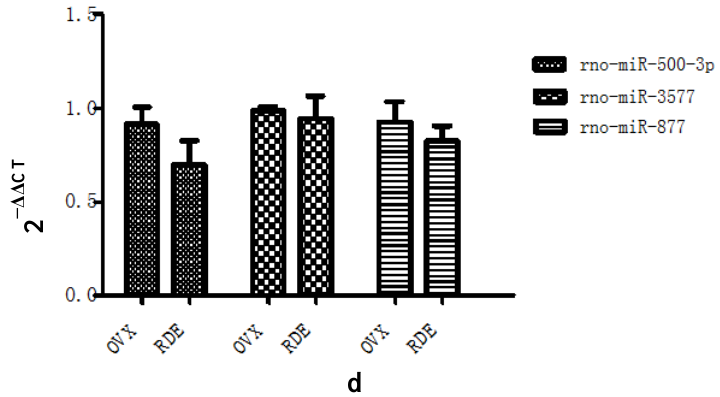
Figure 3. Validation of the differential expression of 13 miRNAs identified in the microarray by qRT-PCR: ( a )–( d ) effect of RDE on the expression of 13 miRNAs ( n = 6 in each group), respectively. * P < 0.05; ** P < 0.01, vs. OVX group.